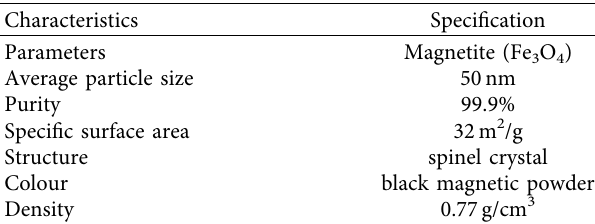
Table 3: General characteristics of the Fe used for pressboard